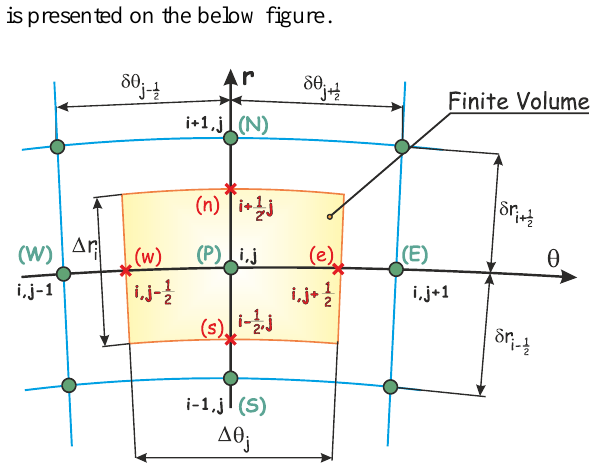
Fig. 2. Diagram of the finite volume